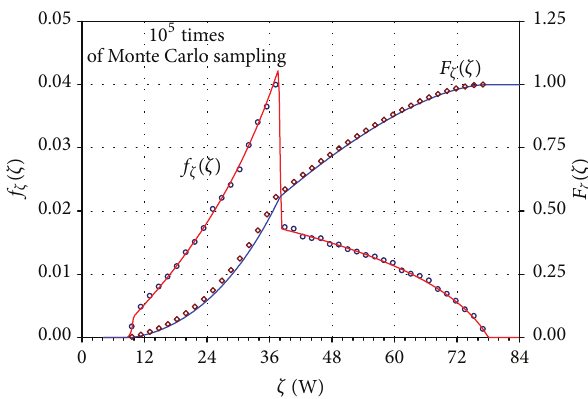
Figure 18: pdf and CDF of the array maximum power obtained from the analytical model (curves) and from the MC simulations (scattered